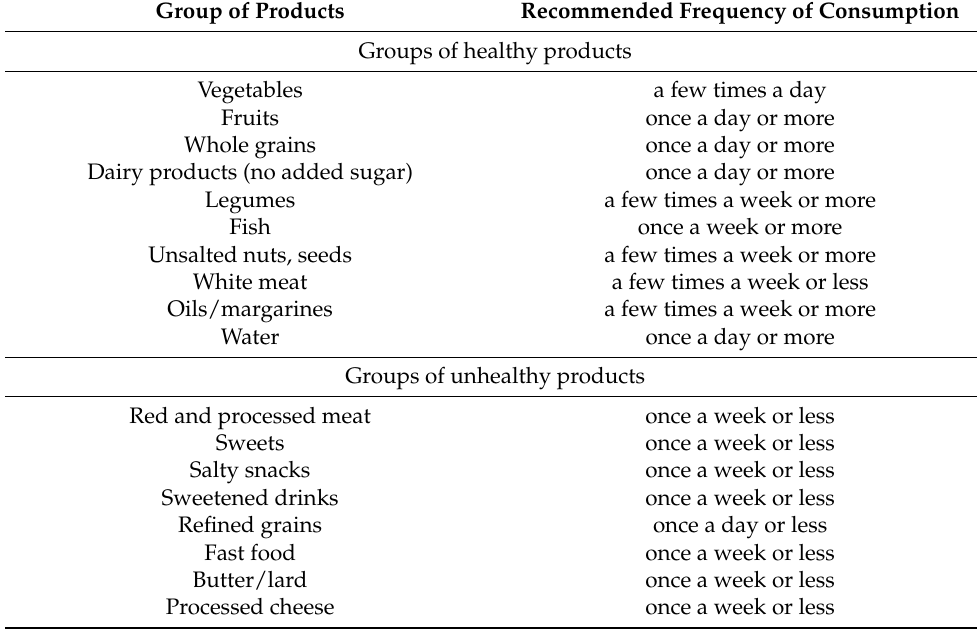
Table 1. The components of the Dietary Guidelines Adherence